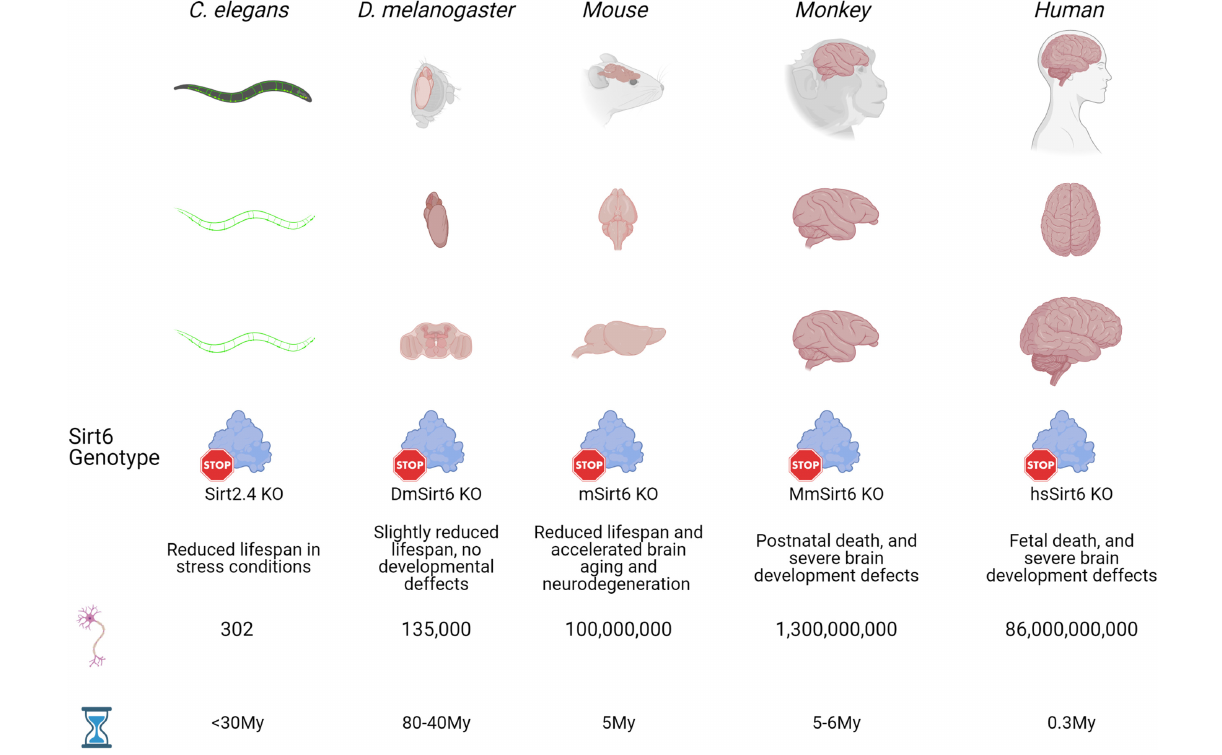
FIGURE 1 | Evolutionary time of model organisms and Sirt6 function. Five well studied organisms ( C. elegans, D. melanogaster , mouse, monkey and human) that appeared at different times during evolution are used here to show how during evolution the brains has become bigger and more complex, with an expected increase in the number of neurons. Also, as brains becomes bigger and the number of neurons increase, the effect of Sirt6 deletion on organism development and life expectancy is more evident. From slight effects on life span from relatively simple organism like worms and flies, to phenotypes with severe neurodevelopmental defects that are incompatible with life in primates. Sirt2.4 is the Sirt6 ortholog in C. elegans , DmSirt6 is the D. melanogaster Sirt6 ortholog, mSirt6 is the mouse Sirt6 ortholog, MmSirt6 is M. Mulatta ortholog, and hsSirt6 is the human